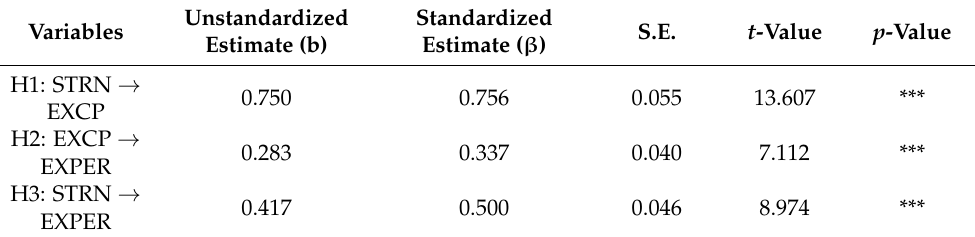
Table 5. Standardized estimate, unstandardized estimate, standard error, t -value, z-value, and p -value.